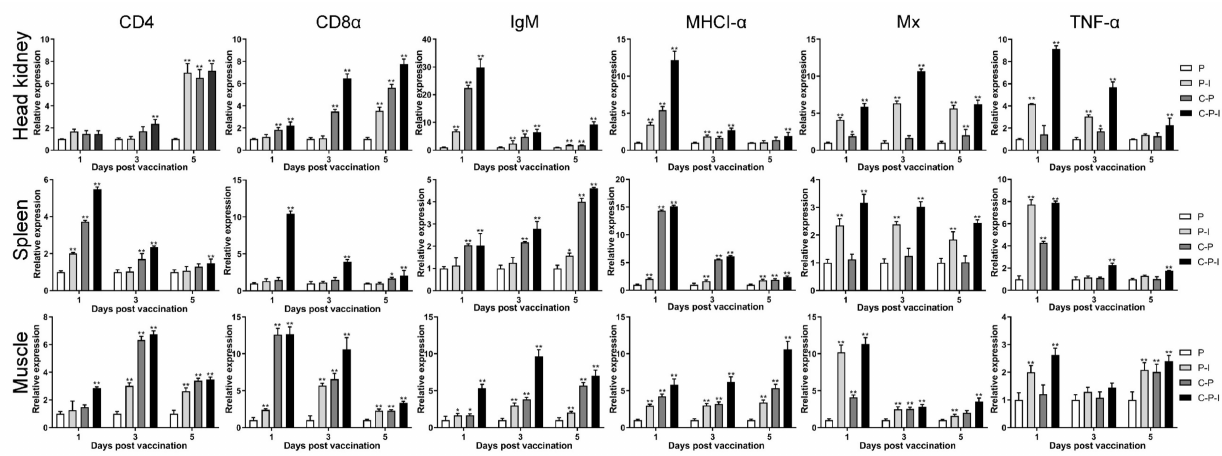
Figure 4. Expression changes of immune-related genes in head kidney, spleen, and muscle of injection site on the 1st/3rd/5th days after immunization. β -actin was used as an internal reference gene. The expression level of each gene in pBudCE4.1 group was set to one. The Y-axis represents the abundance of mRNA expression in fish relative to pBudCE4.1 in each group of fish. Results are shown as mean ± standard deviation of values randomly obtained from three fish. P: pBudCE4.1 group; P-I: pBudCE4.1-IRF3 group; C-P: CP-pBudCE4.1 group; C-P-I: CP-pBudCE4.1-IRF3 group.